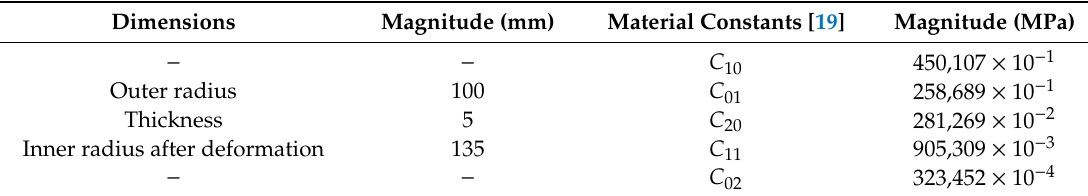
Table 4. Example parameters of the balloon.